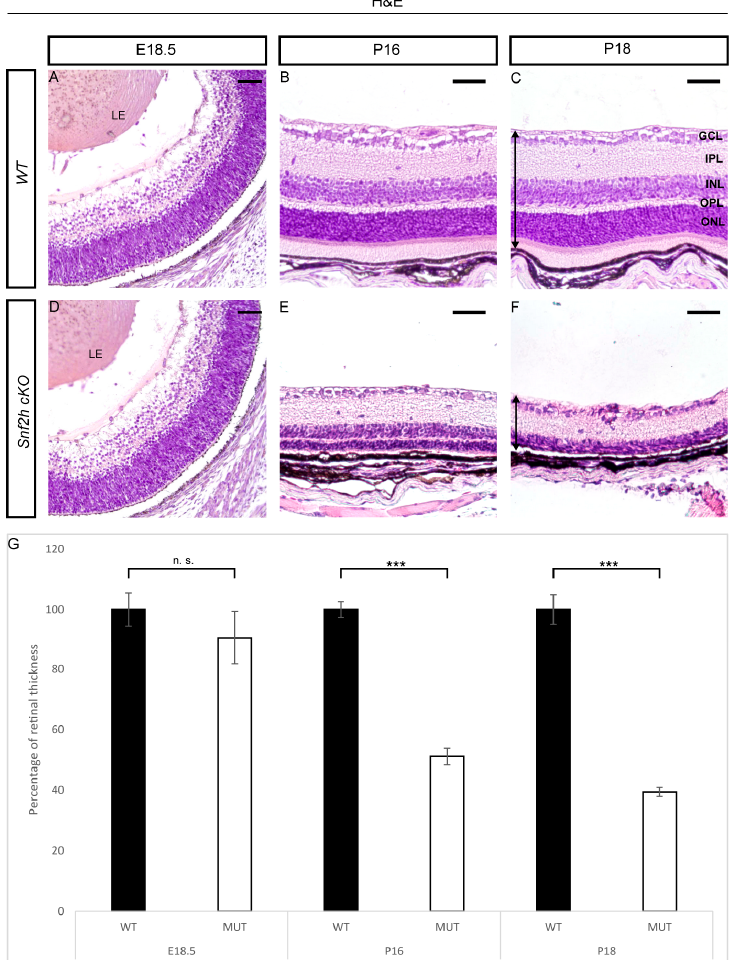
Figure 2. Morphology of Snf2h -deficient retina. Hematoxylin and eosin staining of embryonic and postnatal retinal sections of wild-type and Snf2h cKO was performed to display the retinal morphology. At the time of fully differentiated retinal cell types (P18), Snf2h cKO had dramatically reduced retinal thickness compared with controls ( C , F ). The outer retinal segment of Snf2h cKO mice was completely missing at P18 ( F ). Snf2h -deficient mice maintained the appropriate retinal structure until P16, although the outer nuclear layer (ONL) was almost indistinguishable ( B , E ). Differences in the thickness of the retina were not significant until birth ( A , D , G ). The time course of the retinal thinning is shown in the graph ( G ). The arrows show the range from where the retinal thickness was measured ( C , F ). GCL—ganglion cell layer, INL—inner nuclear layer, ONL—outer nuclear layer, IPL—inner plexiform layer, OPL—outer plexiform layer, and LE—lens. Error bars indicate standard derivation; p -values were calculated using Student’s t -test ( n = 3). *** p < 0.001, n.s. = not signi fi cant. Scale bars: 50 µm.